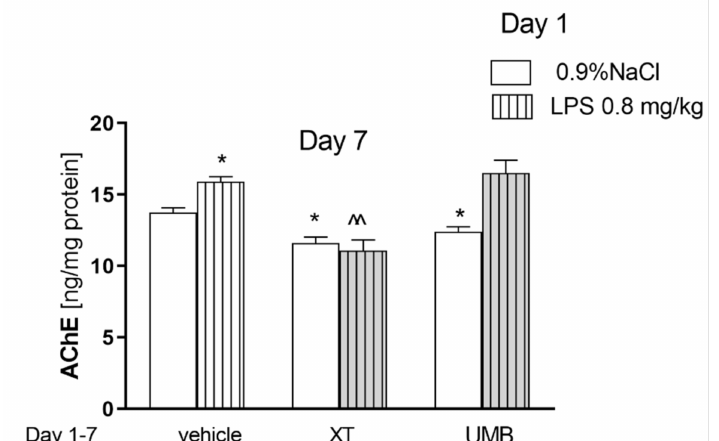
Figure 4. Effects of acute injection of LPS (0.8 mg/kg) and repeated xanthotoxin and umbelliferone (15 mg/kg) alone or in combination on AChE level in the brain. LPS (0.8 mg/kg, i.p.) was adminis- tered on the day 1st, XT and UMB were administered repeatedly (day 1–7). The brains were collected 24 h after the last injection; n = 8–10; the means ± SEM; * p < 0.05 vs. saline-treated control group, ˆˆ p < 0.01 vs. LPS-treated control group, Bonferroni’s test.